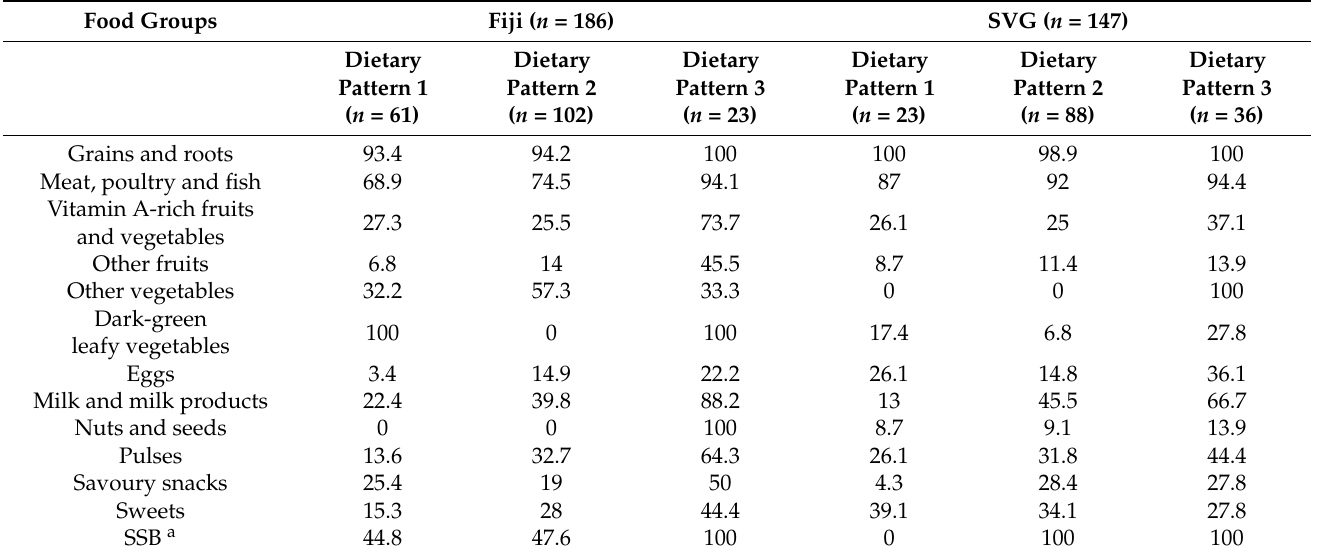
Table 1. Results from latent class analysis based on reported consumption of 13 dietary food groups